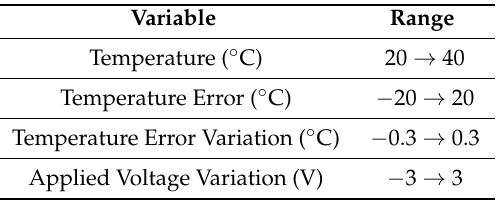
Table 2. Ranges related to each